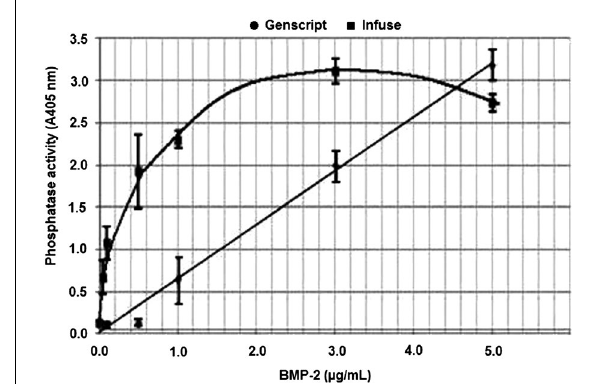
Fig. 6 Biological activity determination of hBMP-2 via induction of alkaline phosphatase activity in murine myoblastic C2C12 cells, reading at 405 nm after 72 h culture. Equations of the assay curves: for E. coli -derived hBMP-2 (GenScript): Y A405 = 0.637X µ g / mL − 0.011 ( r = 0.997 ; n = 5 ; P < 0.001 ) ; ED 50 = 2.5 µ g ; for CHO-derived hBMP-2 (Infuse ® ): Y A405 = 0.682